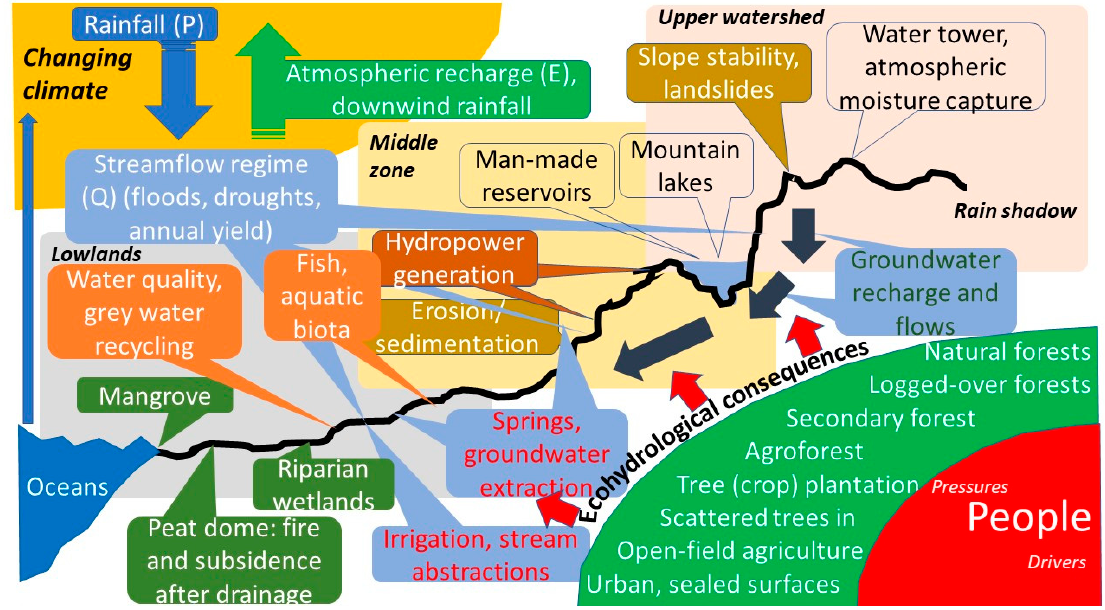
Figure 5. A first synthesis of eco-hydrological relations across the various landscapes in Table 2.